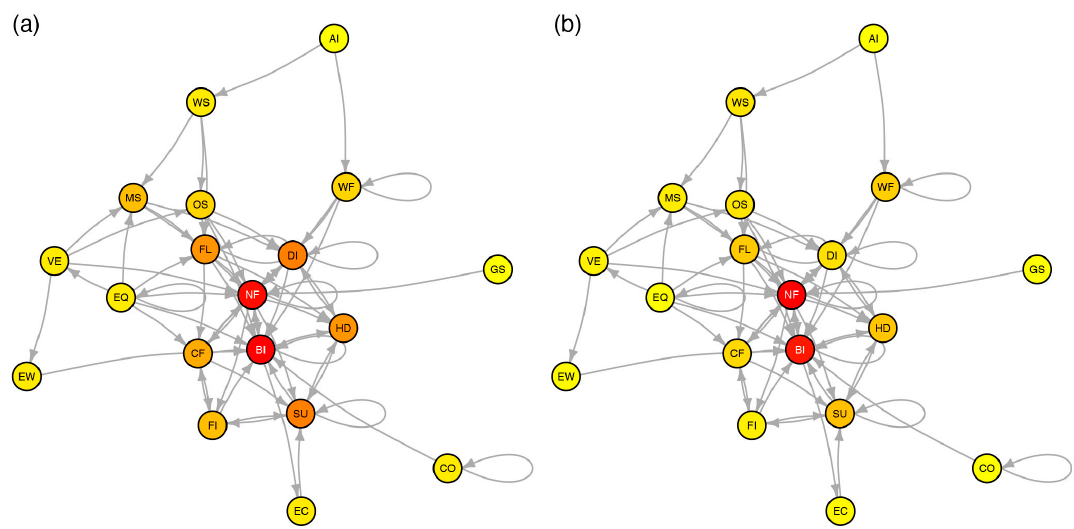
Figure 4. Catastrophe graph G of the reduced adjacency matrix A shown in Figure 3. ( a ) In-degree centrality; ( b ) betweenness centrality. A warmer color represents a higher centrality value; see Table 1 for peril identifier definition.